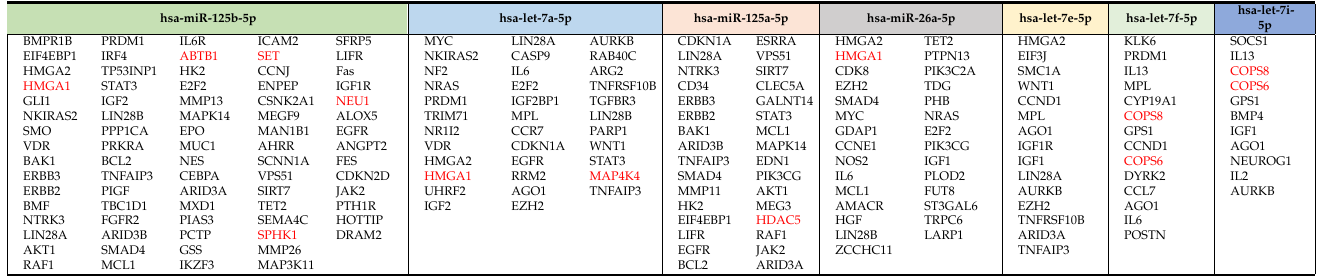
Table 3. Network analysis of all seven significantly down-regulated miRs (miR and genes). Analysis was done with MIENTURNET and miRTarBase, setting “strong evidence categories”, 0.05 as a threshold for the adjusted p -value (FDR). Transcripts from genes in red were found to be significantly upregulated after hypoxic pretreatment (Supplementary Table S2).